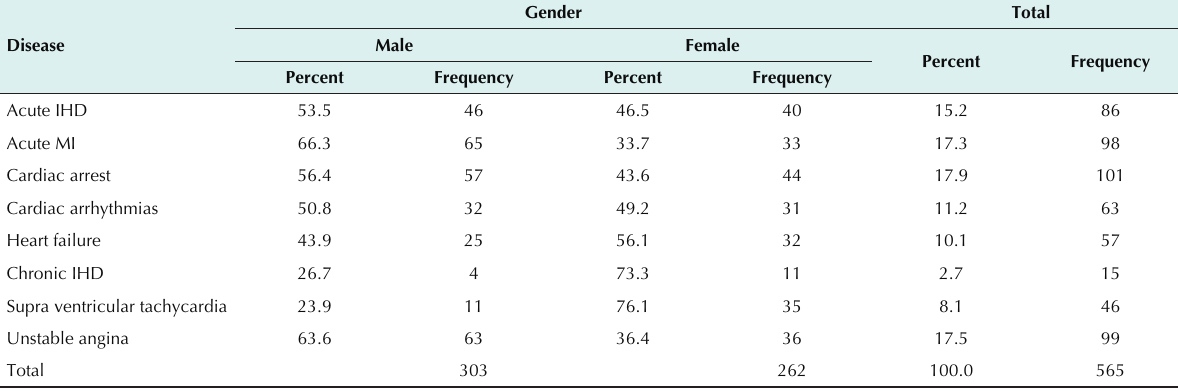
Table 2. Percentage and Frequency of Patients With Cardiovascular Diseases According to Gender